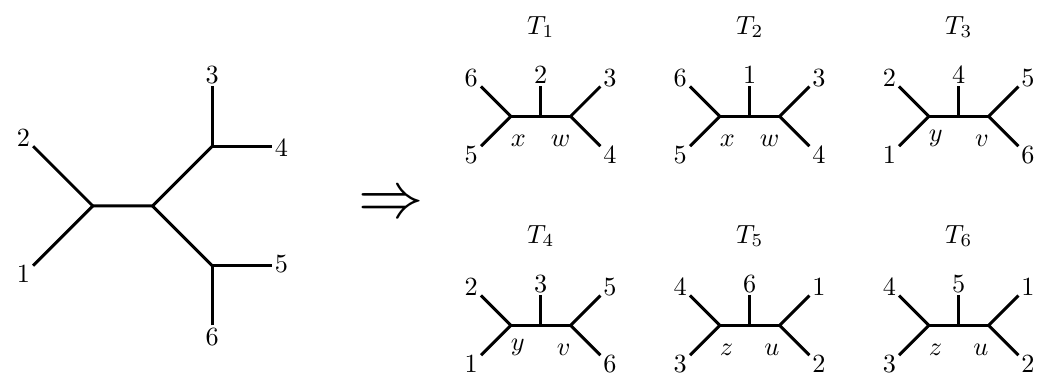
Figure 7 . Snowflake tree (left) and associated planar collection